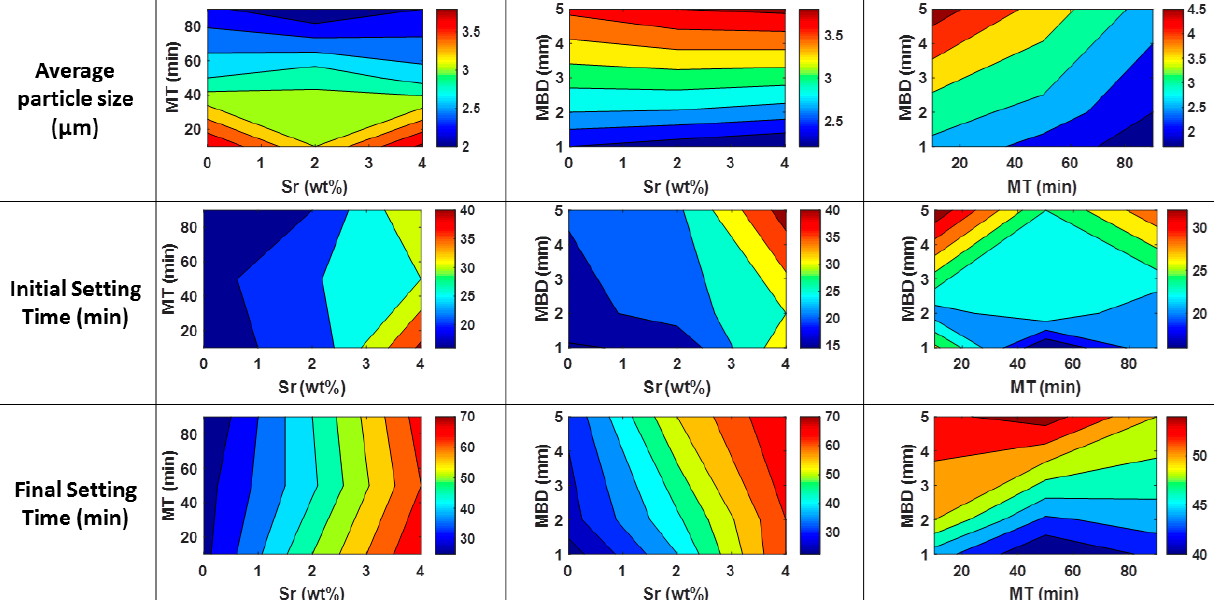
Figure 5. Contour plots related to the Powder Milling scheme: The effects of strontium amount (Sr), milling time (Mt), and milling balls diameter (MBD) on the average particle size (first row), and initial and final setting times (second and third row, respectively). The output variables are represented, as reported in the colored scale bars, from blue (lower values) to red (higher values).